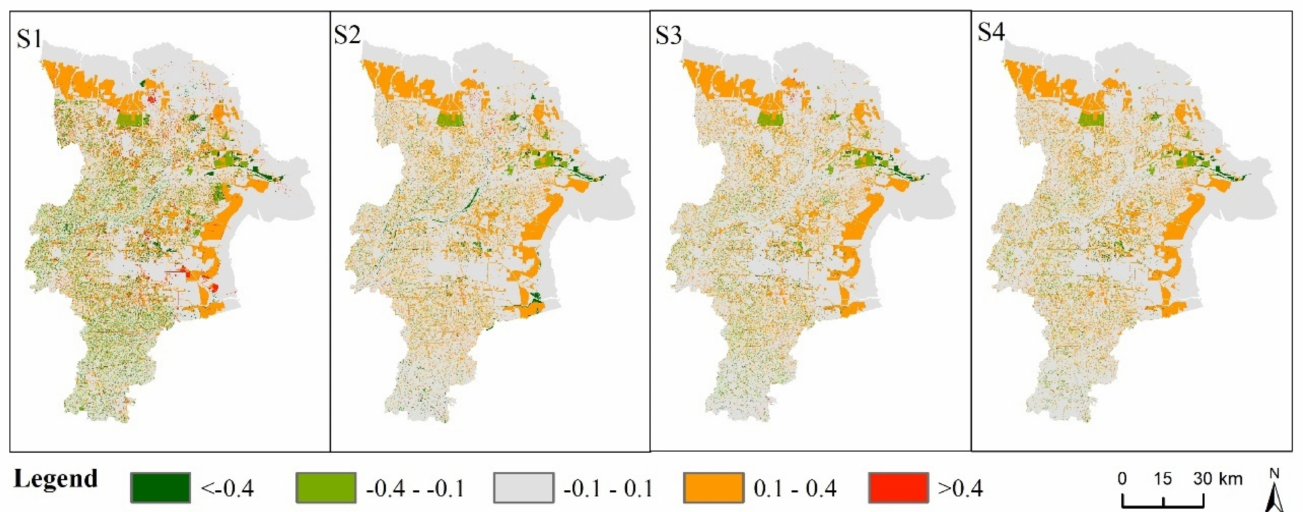
Figure 9. Spatial changes of habitat quality relative to 2017 in Dongying City in ( S1 ) ( S2 ), ( S3 ), and ( S4 ). Note: S1 , S2 , S3 and S4 refer to the business as usual scenario, the fast-cultivated land expansion scenario, the ecological security scenario and the sustainable development scenario,